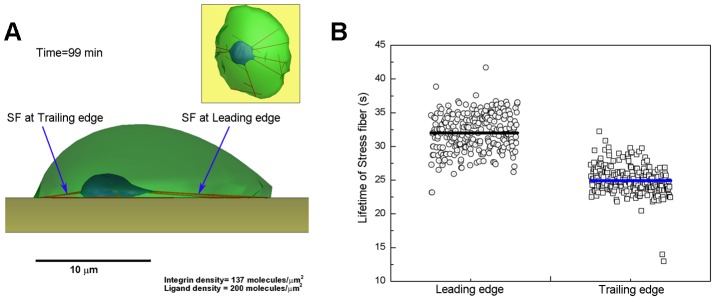
Actin motor activity in the model.A) An example of simulated cell migration on the plate showing that two types of stress fibers connected to the nucleus are anchored at both leading and trailing edges, and a schematic in the inset representing distributions of SFs in the cell in a top view. B) A scatter plot showing the lifetime of SFs at both leading and trailing edges. black and blue colored bold lines indicate averages values of 32.00 s and 24.91 s at the leading and trailing edges, respectively. Statistical data were acquired from 266 focal adhesions sites at the leading edge and 245 focal adhesions sites at the trailing edge during 3 hours of simulated cell migration on the plate.